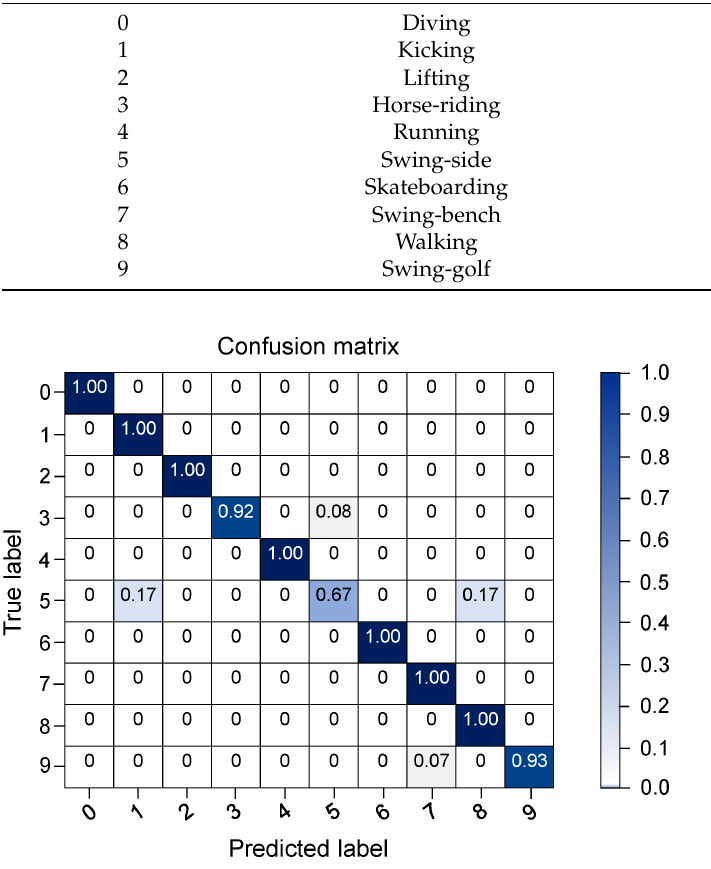
Figure 8. The confusion matrix of the proposed methodology for the UCF Sports